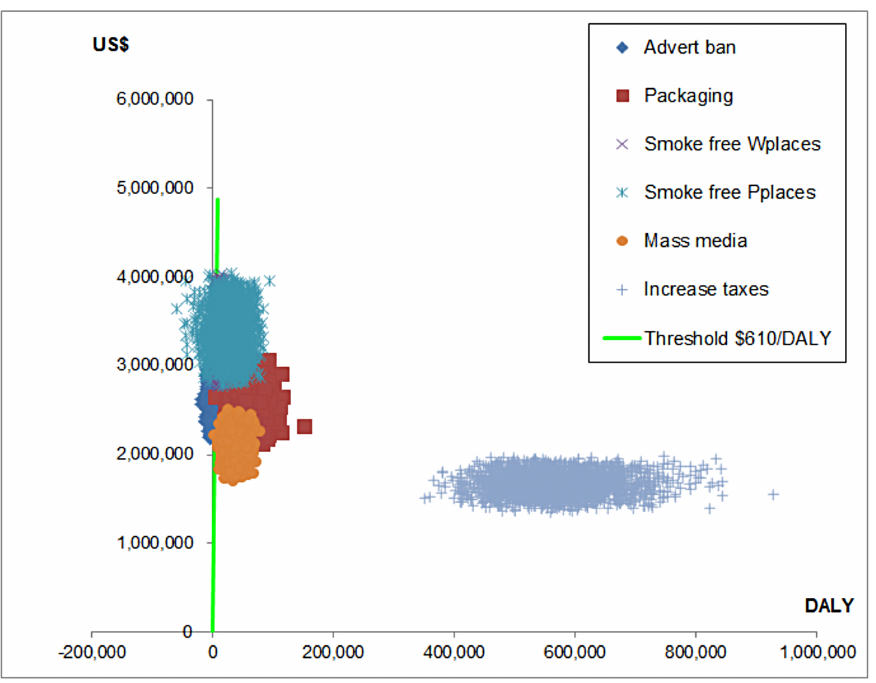
Fig 4. Cost effectiveness scatter plot for the tobacco control strategies. Wplaces = work places, Pplaces= public places.